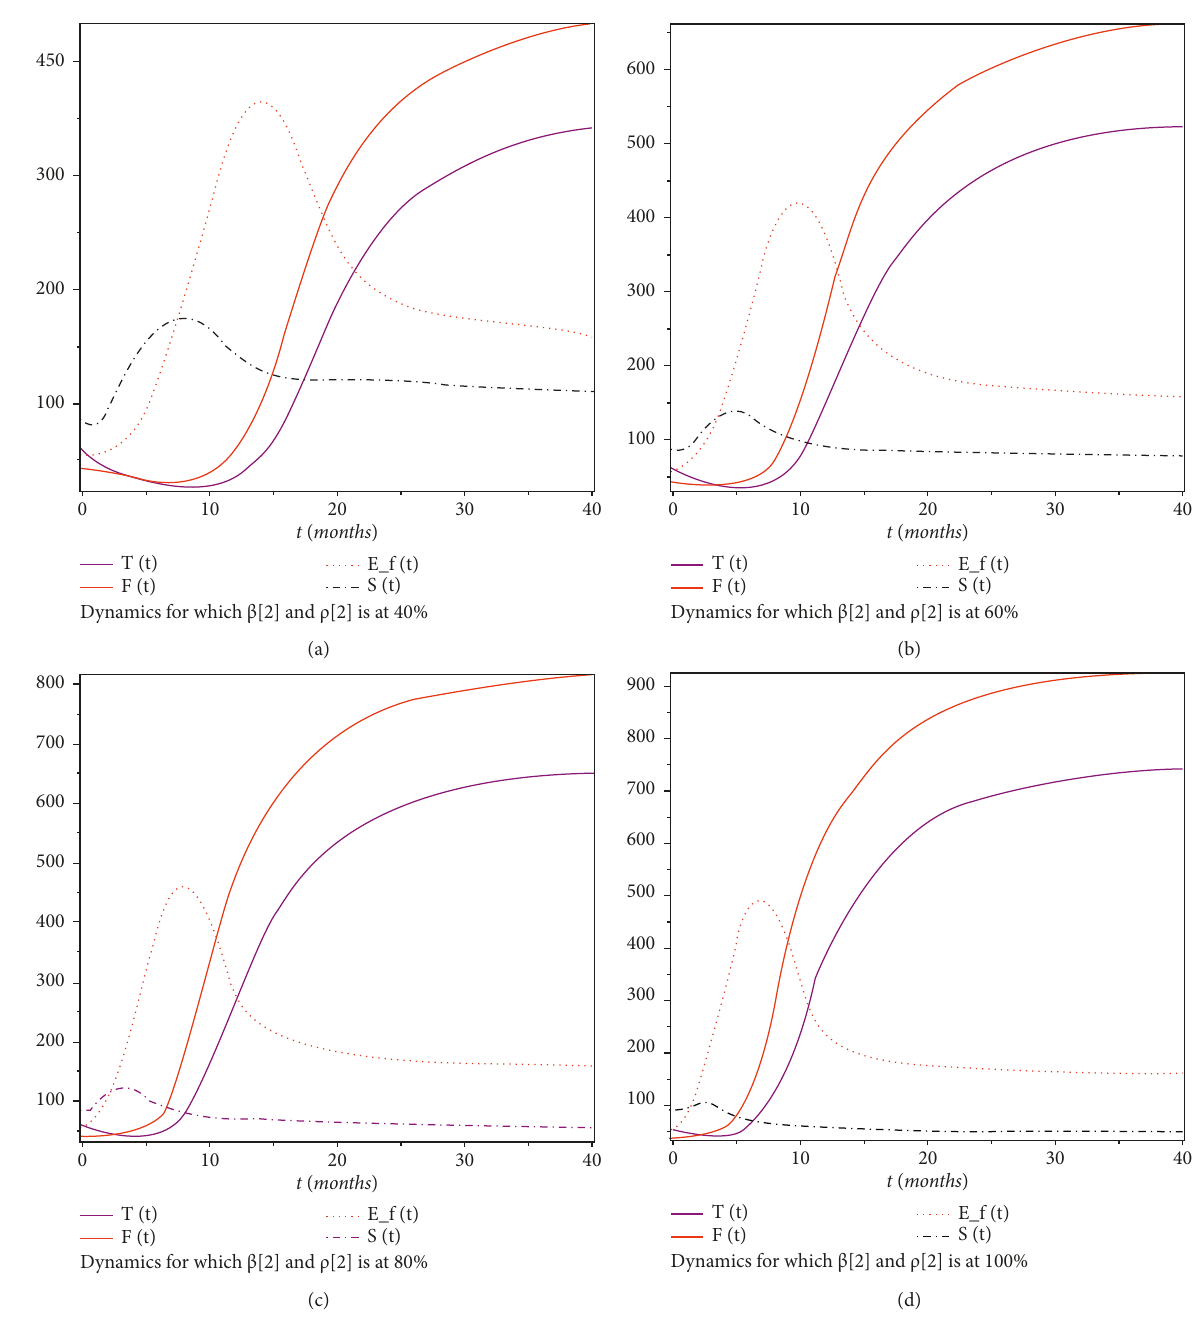
Figure 4: Revealing the output of simulation when successful efforts of fanatical is gaining sympathy and recruitment into the ideology. (a) simulation at double efforts at a scenario of Figure 3(d) (i.e. 40% effort and success rate) resulted in drastically increase in the dynamics of fanatics and terrorism, (b) Presents growth rate in fanatics and terrorism group as efforts and success rate grows to 60%, (c) dynamics of core group with progression in contact and success rate of recruitment, (d) displays adequate contact rate ( β fanaticism ( ρ ). This illustrates that for adequate contact rate will cause a progressive growth in fanaticism and consequentially, the society will note enjoy a stable